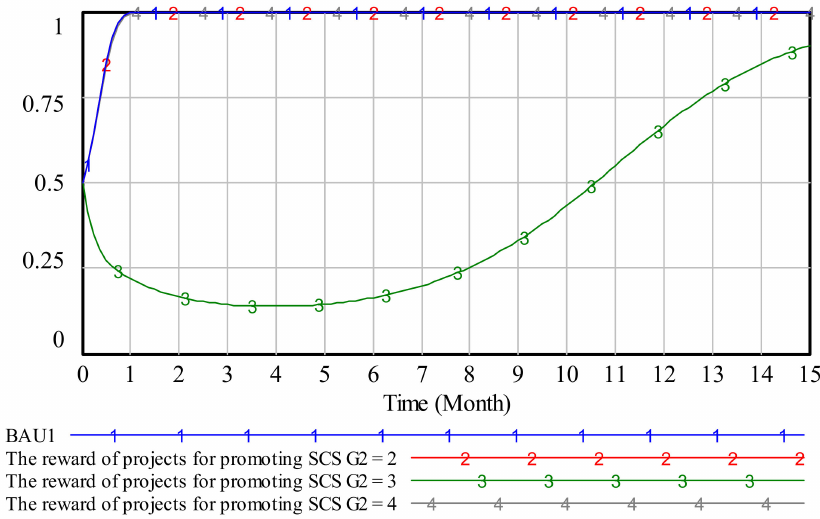
Figure 9. Impact of G 2 on the enterprise strategy selection in the BAU1 scenario.